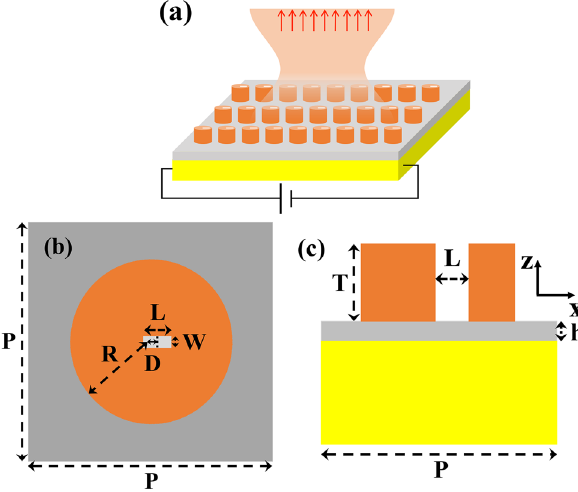
Figure 1: (a) The schematic diagram of the ultra-narrow bandwidth THz thermal emitter, assisted by the BIC mode supported by the Si slotted disk array; the orange output beam represents the thermal emission at the BIC resonance. (b) and (c) Top and cross-sectional views of Si slotted disk array unit cell,